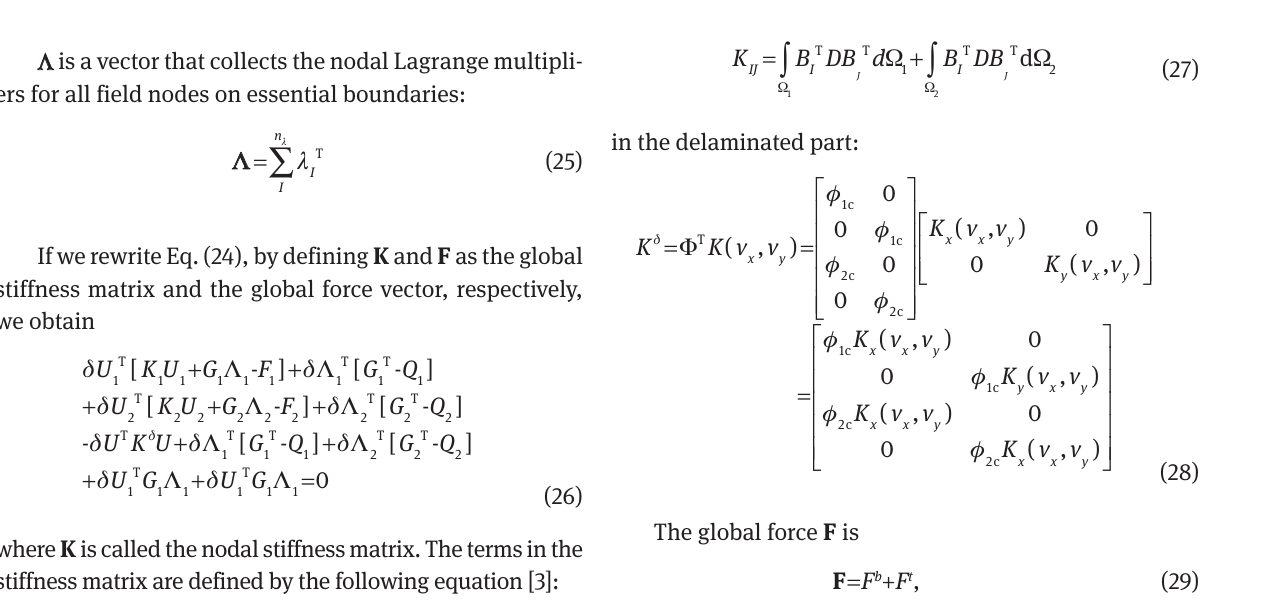
Figure 6 Energy release rate-load diagram for carbon/epoxy (AS4/3501-6) obtained from meshfree